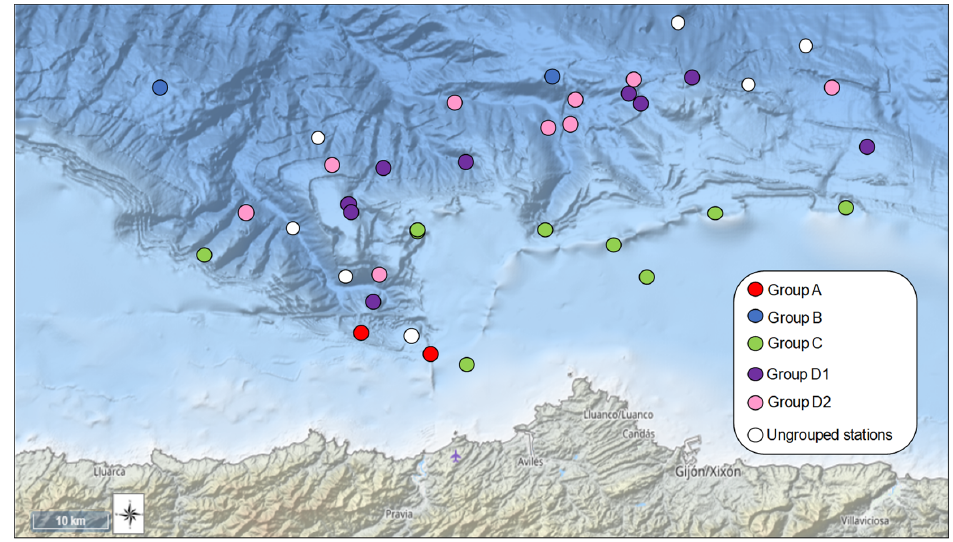
Figure 4. Location of sampling sites in the ACS showing the groups determined by cluster analysis.